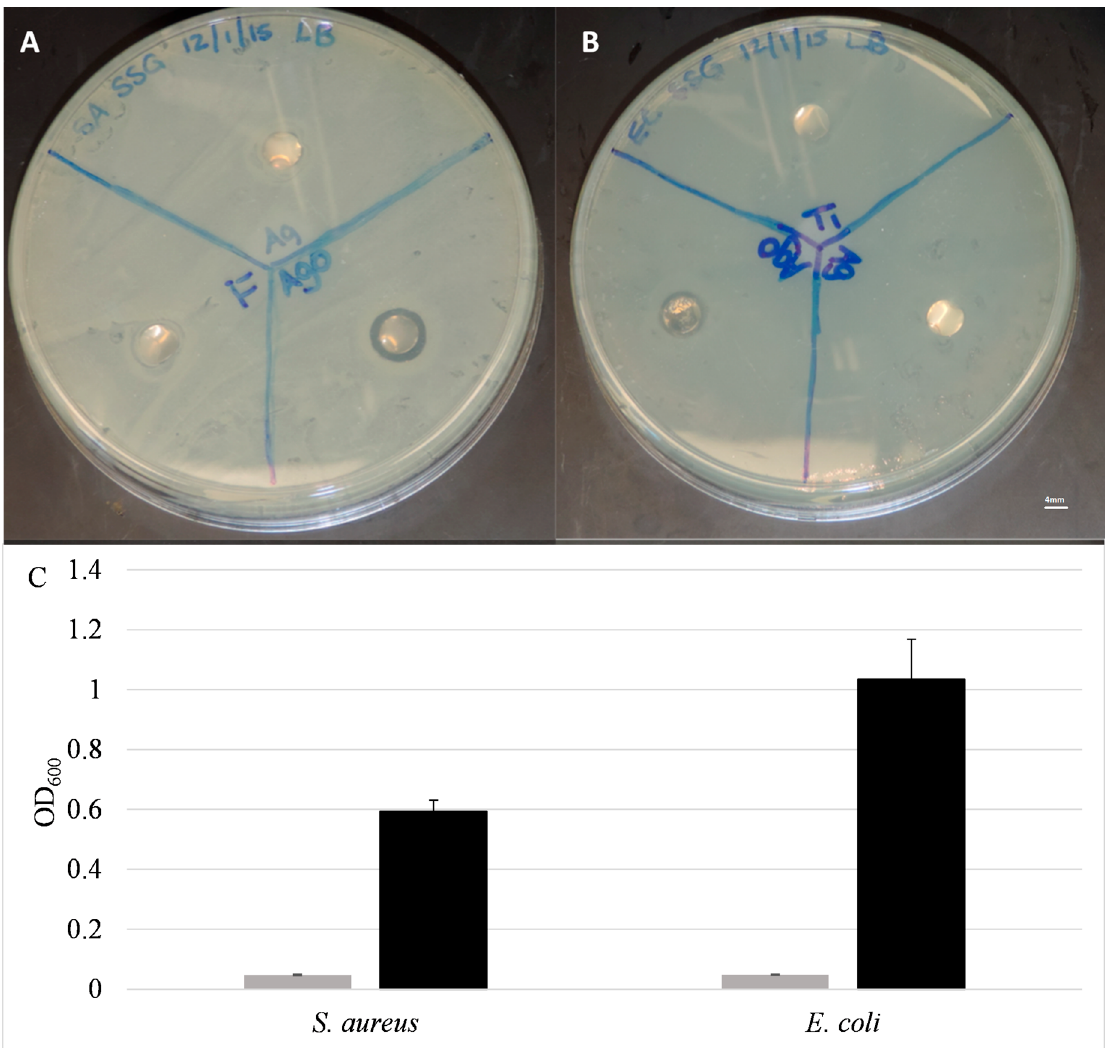
Figure 4. Antimicrobial activity of Ag x O coatings ( A , B ) Zone of inhibition assay. Images of LB plates seeded with ( A ) Staphylococcus aureus or ( B ) Escherichia coli . The Ag x O disc (labeled AgO on the plates) exhibited a zone of inhibition (ZOI) of ( A ) 9 mm for S. aureus ; ( B ) 10 mm for E. coli . The diameter of the disc in each case is 6.5 mm (1/4”). No ZOIs were evident for Ag-coated or Ti control discs; ( C ) Overnight growth of S. aureus and E. coli in modified minimal inhibitory concentration (MIC) experiment. Gray bars represent cultures exposed to Ag x O-coated discs while black bars represent cultures exposed to uncoated Ti discs. Data are averages of at least three samples.